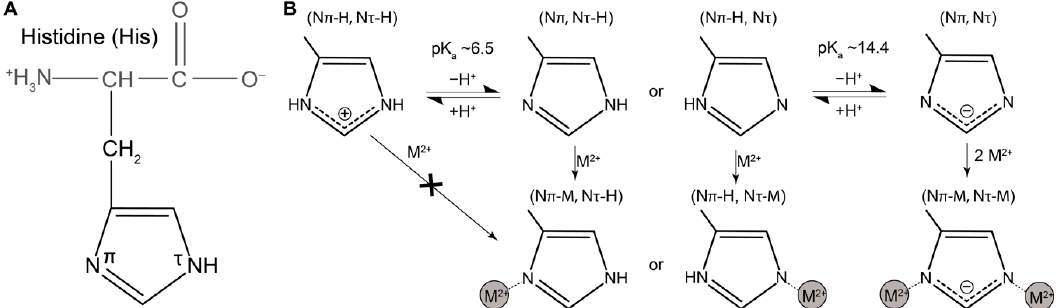
Figure 1. Histidine chemistry and metal binding. ( A ) Chemical structure of the amino acid histidine (His) under physiological conditions (pH ≈ 7.5). ( B ) Depending on pH and other solution conditions, the histidine imidazole side chain can exist in a number of forms. Metal (M 2+ ) binding can only occur when a proton is lost from at least one nitrogen atom.